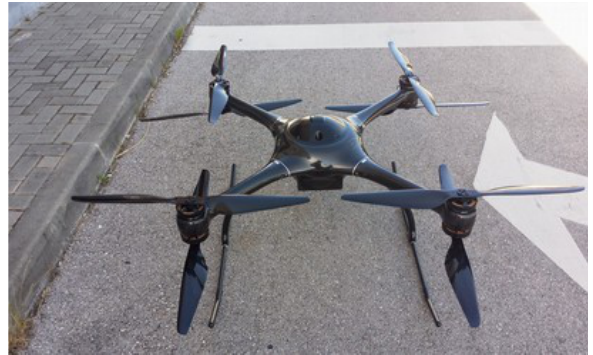
Figure 1. UX-Spyro-8, by UAVision